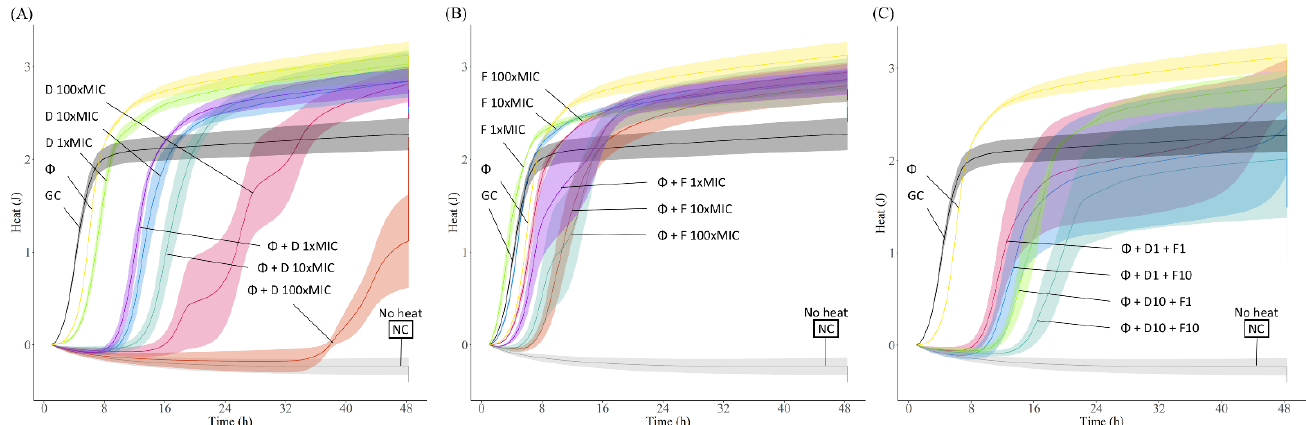
Figure 5. Heat (J) curves of EF 04 biofilm exposed to ( A ) phage CUB_EF04 ( Φ at 10 8 PFU/mL) plus daptomycin (D) at different concentrations (1 × , 10 × or 100 × MIC), ( B ) phage CUB_EF04 ( Φ at 10 8 PFU/mL) plus fosfomycin (F) at different concentrations (1 × , 10 × or 100 × MIC), or ( C ) phage CUB_EF04 ( Φ at 10 8 PFU/mL) plus both antibiotics at different concentrations (1 × , 10 × MIC). Each curve shows the heat produced by viable bacteria in the biofilm after 24 h of treatment. GC represents the growth control sample not exposed to any antimicrobials. NC represents de negative control for media sterility. Data are expressed as mean ± SE. Plots were prepared using RStudio [30]. Solid lines represent the mean and corresponding shaded regions the standard error.